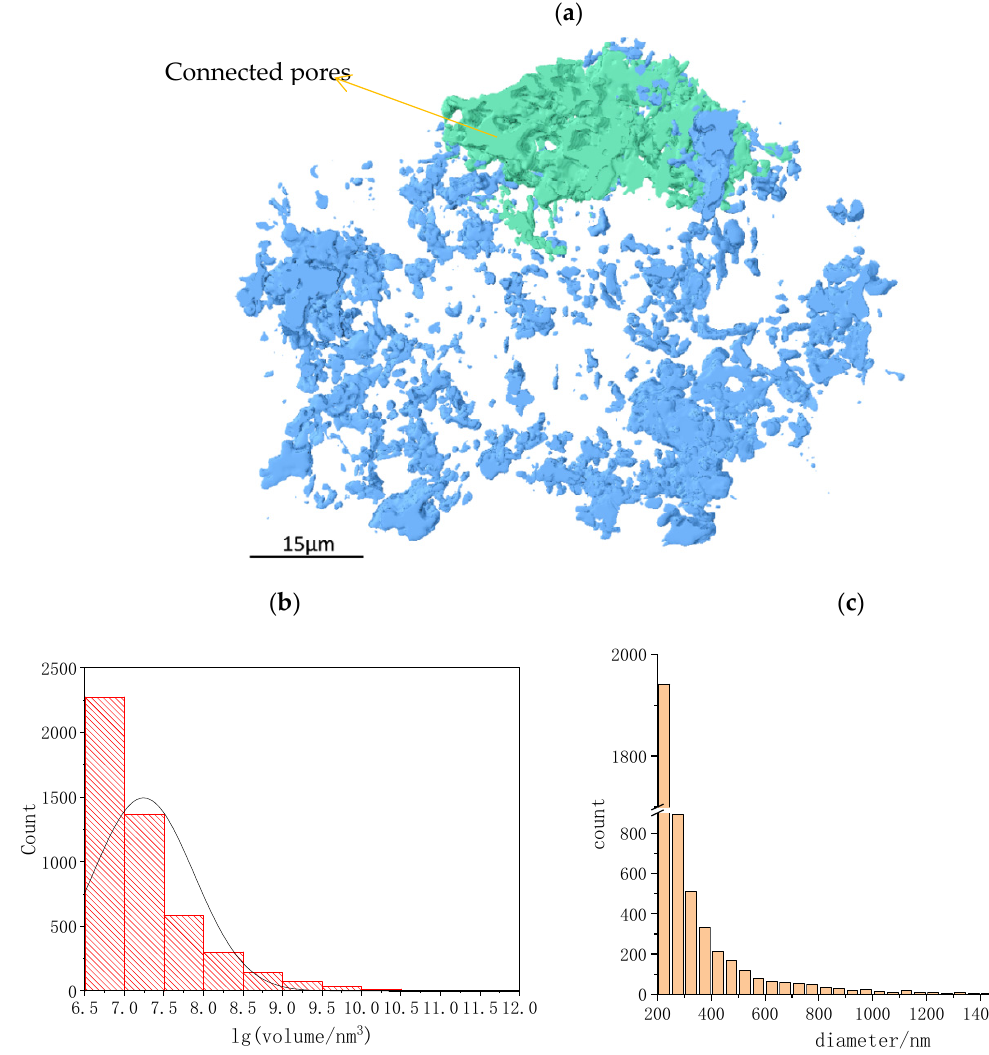
Figure 4. 3D image and analysis of pores: ( a ) 3D image of connected pores rendered in green and non-connective pores rendered in blue, ( b ) the volume distribution of all pores, and ( c ) the diameter distribution of all pores.